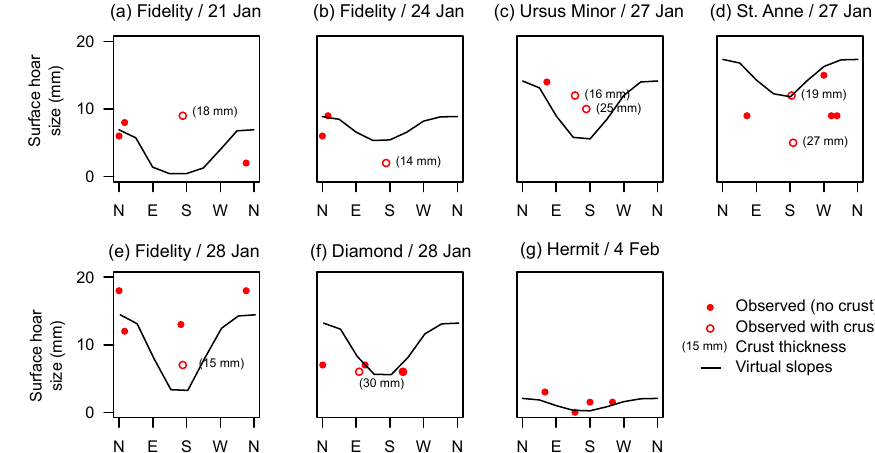
Figure 10. Surface hoar sizes observed at treeline elevations over different slope aspects during seven field campaigns. Surface hoar sizes observed without underlying sun crusts are shown with solid red dots, while surface hoar sizes observed with underlying sun crusts are shown with hollow red dots (and the thickness of the crust to the right). Black lines show the median size modelled on slopes at eight cardinal aspects with 30 ◦ inclines. Slope simulations were done with forecast data from grid points at treeline elevations within a 10km radius of the